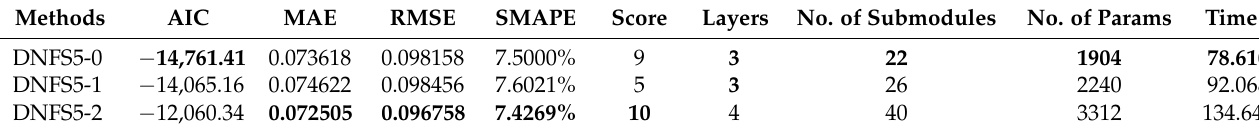
Table 7. The performance of DNFSs with different shared inputs on Test Dataset No.